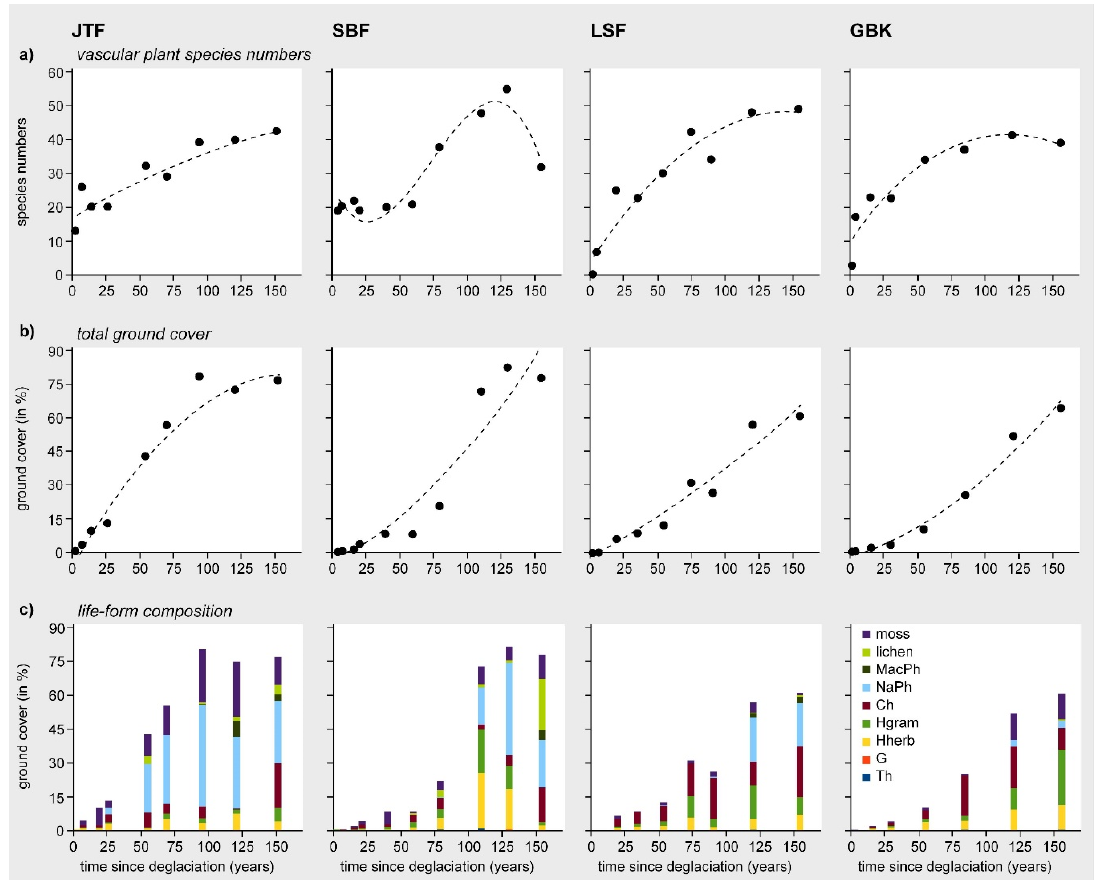
Figure 4. Change of species richness ( a ), ground cover ( b ), and life-form composition ( c ) (for description see 2.2 vegetation data) with time since deglaciation within the four glacier forelands studied.